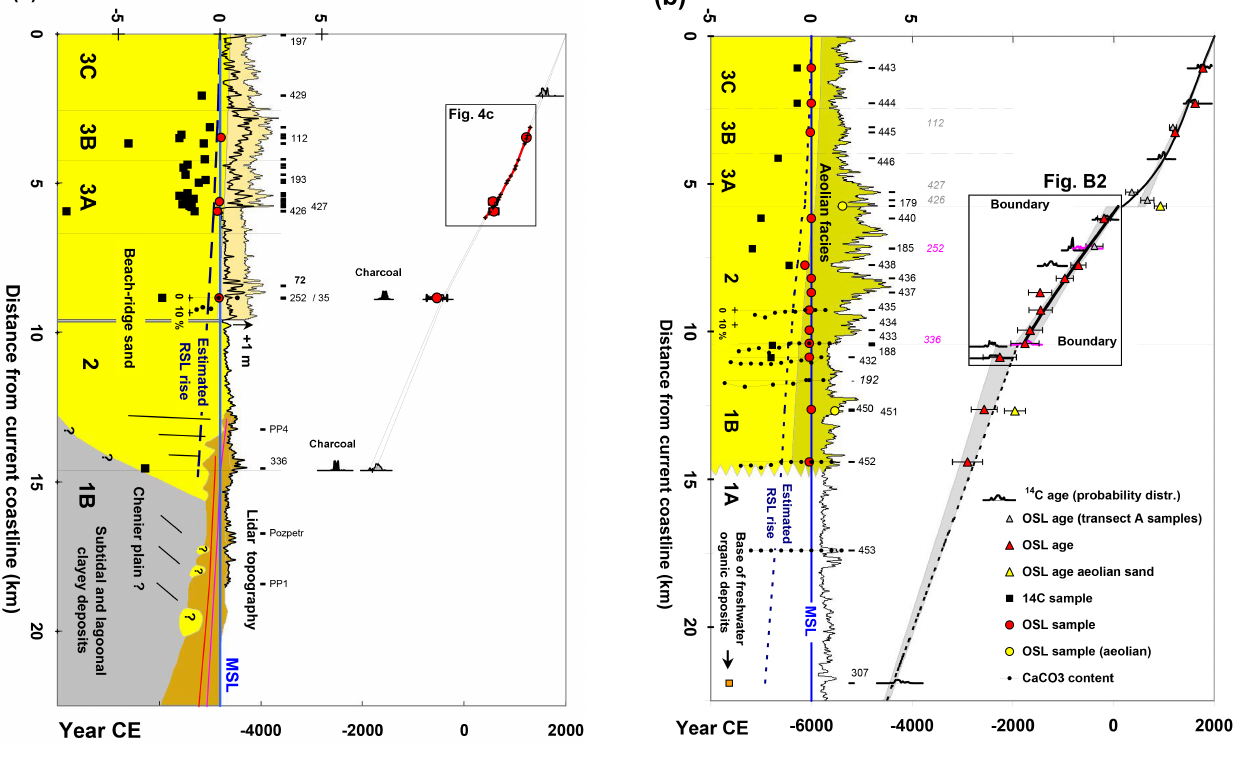
Figure 3. Age–distance models for Transects A (a) and B (b) . Indicated are the 1 σ distributions for the model results using the P_sequence module in Oxcal 4.2 (Bronk Ramsey, 2009). Sample lo- cations of AMS 14 C (black squares) and OSL (red dots) samples are indicated, and projected samples are presented in italics. The cali- brated 14 C ages are indicated with the full probability distribution and the OSL ages (red and yellow triangles) with their 1 σ range. CaCO 3 content for selected core samples indicates pedogenic de- calcification depth used to estimate the position of m.s.l. during beach-ridge formation. The dashed trendline is based on Gischler and Hudson’s (2004) reconstruction of late Holocene